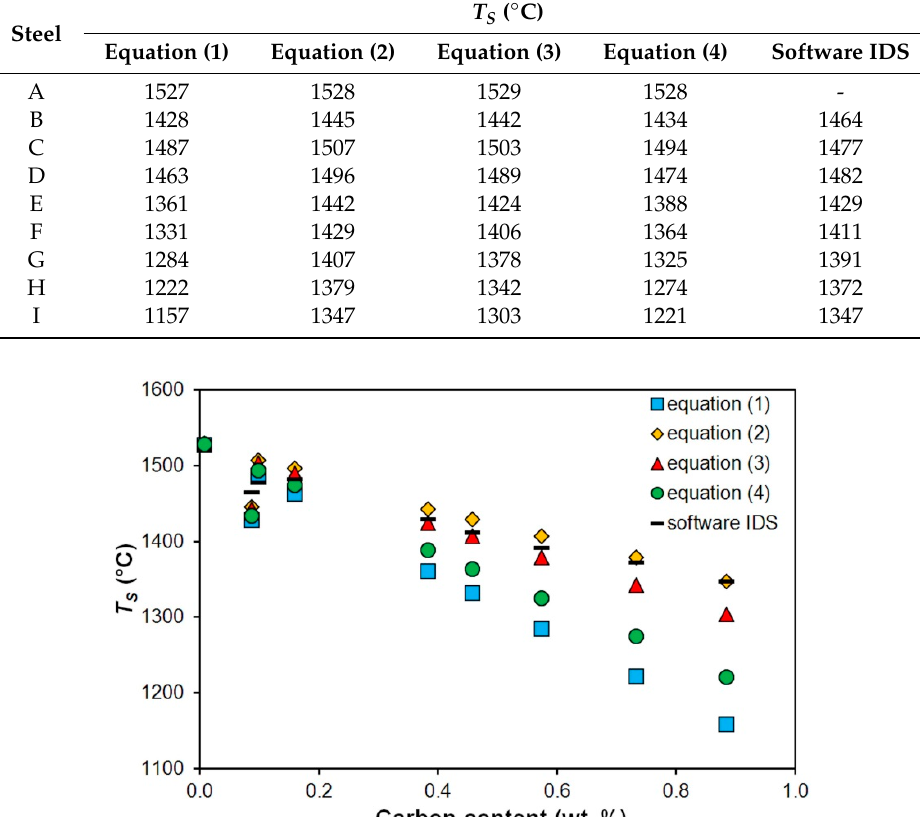
Figure 5. Comparison of the calculated solidus temperatures of the investigated steels.